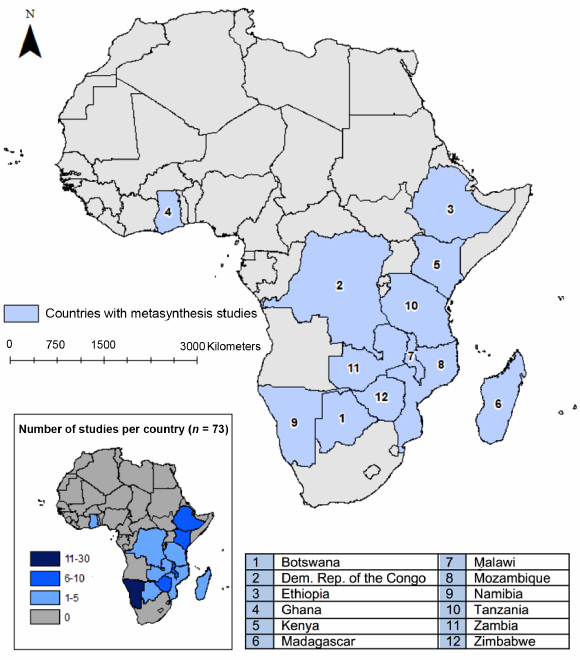
Fig. 3 . Location and number of cases included in the